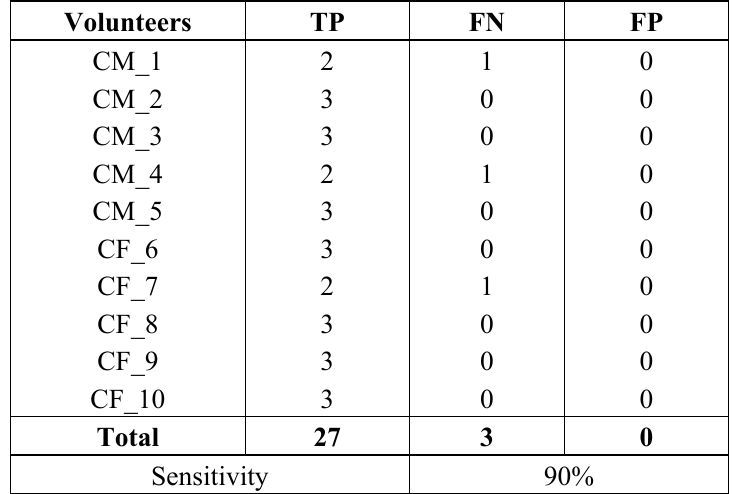
Table 8. The statistics of falling ADL detection for subjects of Table 1 Set 3 in the continuous unscripted ADL experiment.